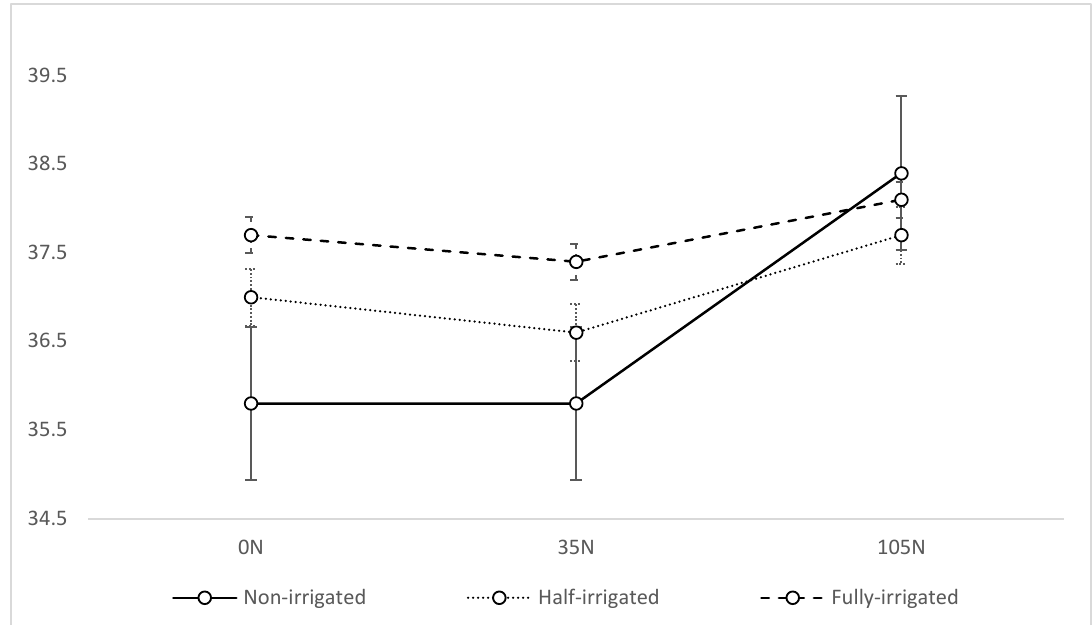
Figure 2. The effect of different fertilization rates on the seed protein concentration (%) of soybean (cv. Figure 2. The e ff ect of di ff erent fertilization rates on the seed protein concentration (%) of soybean Pannonia Kincse) under different irrigation regimes, averaged among 2017, 2018 and 2019 in (cv. Pannonia Kincse) under di ff erent irrigation regimes, averaged among 2017, 2018 and 2019 in Debrecen, Hungary. Debrecen,